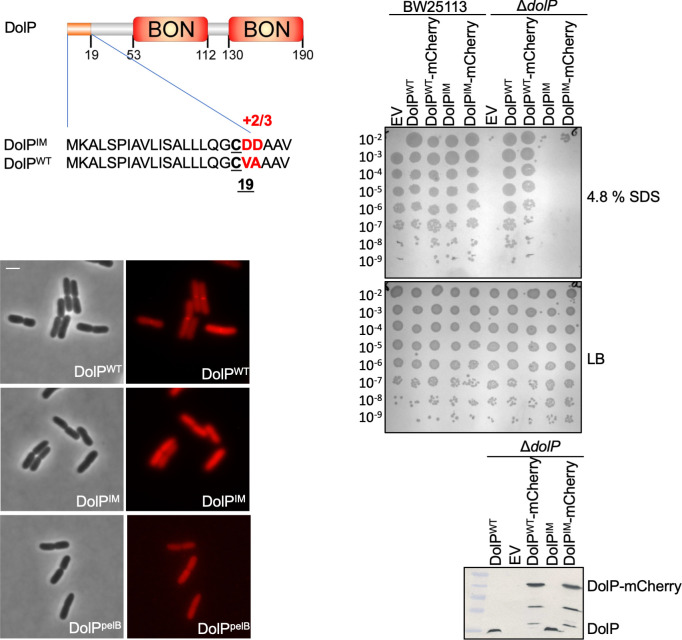
Localisation of DolP to the OM is required for function.The signal sequence and domain architecture of DolP are shown. The sequence changes to pET17b-dolPWT to create the construct targeting DolP to the IM (pET17b-dolPIM) are shown in red. The signal sequence of dolP was also swapped for that of pelB in order to create the construct pET17b-dolPpelB in order to target DolP to the periplasmic space with no modification. Fluorescence microscopy of ΔdolP cells expressing either DolPWT-mCherry or DolPIM-mCherry or DolPpelB-mCherry from the pET17b plasmid after growth to mid-exponential phase (OD600 ~0.4–0.8). Scale bars represent 2 μM and both phase contrast and the mCherry channel are shown in greyscale and red, respectively. The capacity of DolPWT, DolPIM, DolPWT-mCherry or DolPIM-mCherry to complement the ΔdolP mutant sensitivity phenotype was screened by dilution assay on 4.8% SDS. The expression of each construct was checked by Western blotting of total protein extracts with anti-DolP antiserum.Figure 1—figure supplement 5—source data 1.The influence of signal sequences on DolP localisation.